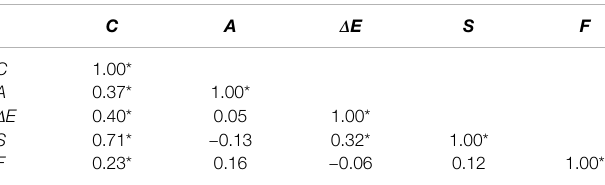
TABLE 3 | Correlation matrix for independent variables in sampled elevated homes in Louisiana, 2005 –